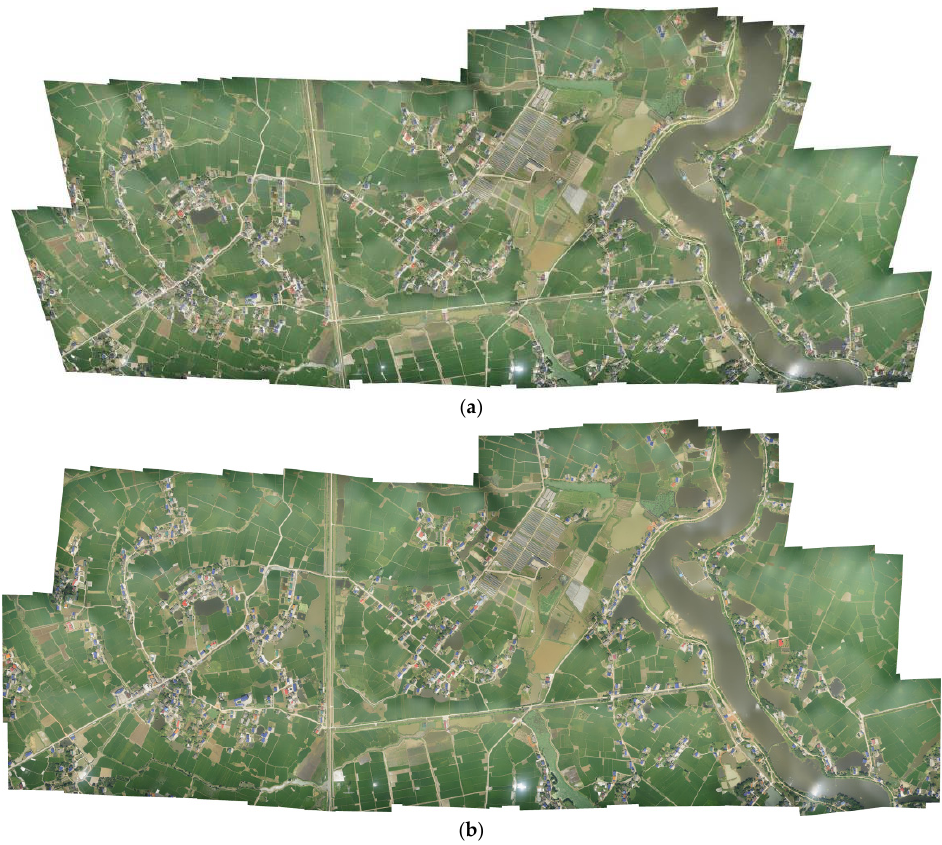
Figure 6. Mosaicking result of Dataset 2: ( a ) mosaicking result via Capel’s method; and ( b ) mosaicking result using the proposed algorithm.